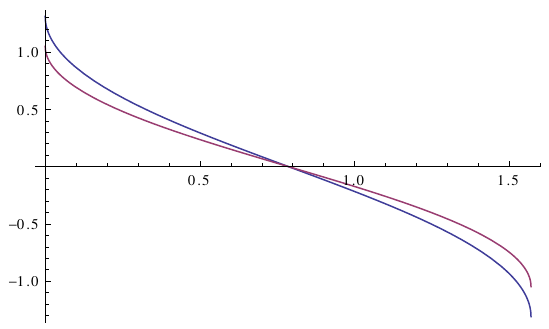
(cid:0) 1 (cid:0) (cid:25) (cid:1) (cid:1) (cid:0) 2 x j 2 , plotted over the range (0 ; (cid:25)= 2). The red line 2 2 (cid:0) 1 (cid:0) (cid:25) (cid:1) (cid:1) (cid:0) 2 x j 2 , plotted over the same range, with K 1 2 = 0 : 8. 2 2